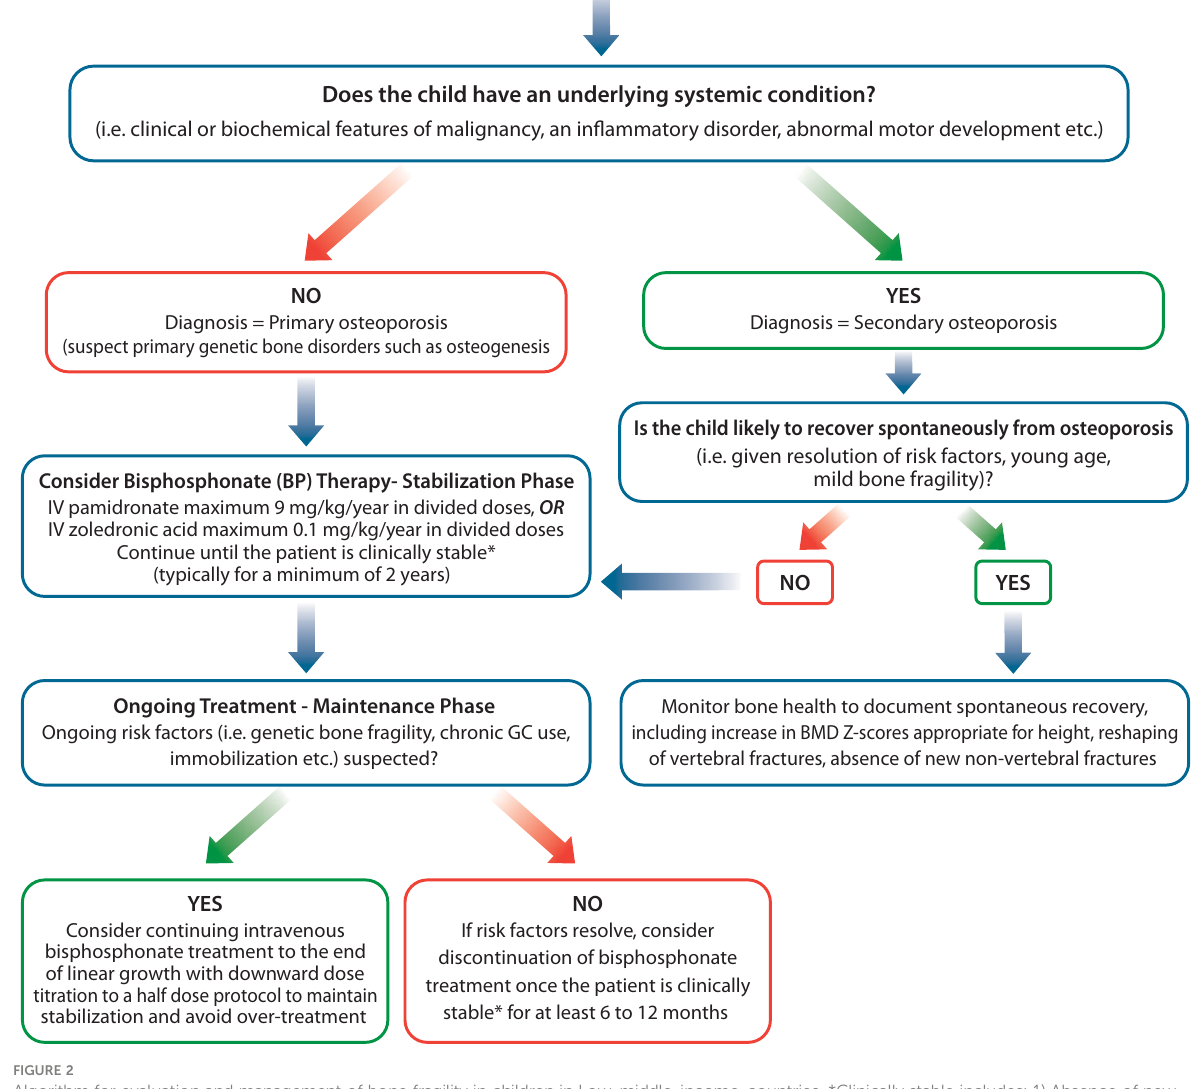
FIGURE 2 Algorithm for evaluation and management of bone fragility in children in Low-middle-income-countries. *Clinically stable includes: 1) Absence of new VF in previously normal vertebral bodies and absence offurther loss of vertebral height at sites of previous fractures, 2) Reshaping of vertebral fractures, 3) Absence of new non-vertebral fractures, bone pain and back pain, 4) Improved mobility, increases in spine BMD Z-score appropriate for